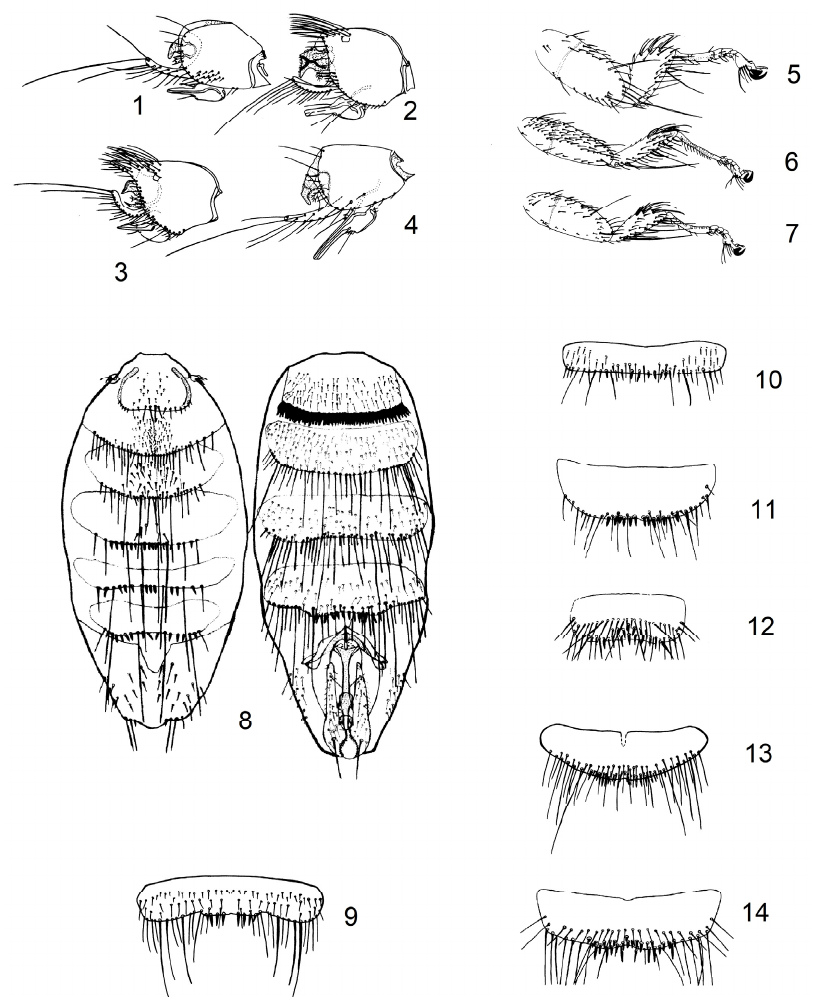
Figure 1. ( 1 ) Nycteribia ( Nycteribia ) latreillii (Leach, 1817), head; ( 2 ) Penicillidia ( Penicillidia ) dufourii dufourii (Westwood, 1835), head; ( 3 ) Penicillidia ( Penicillidia ) monoceros Speiser, 1900, head; ( 4 ) Nycteribia ( Acrocholidia ) vexata Westwood, 1835, head; ( 5 ) Nycteribia ( Nycteribia) kolenatii Theodor and Moscona, 1954, leg; ( 6 ) Phthiridium biarticulatum Hermann, 1804, leg; ( 7 ) Basilia nana Theodor and Moscona, 1954, leg; ( 8 ) Nycteribia ( Nycteribia ) pedicularia Latreille, 180, male, ventral abdomen with claspers; ( 9 ) Basilia nattereri Kolenati, 1857, male, sternite 5; ( 10 ) Basilia nana Theodor and Moscona, 1954, male, sternite 5; ( 11 ) Basilia mediterranea Hurka, 1970, male, sternite 5; ( 12 ) Basilia daganiae Theodor and Moscona, 1954, male, sternite 5; ( 13 ) Basilia italica Theodor, 1954, male, sternite 5; ( 14 ) Basilia mongolensis nudior Hurka, 1972, male, sternite 5.